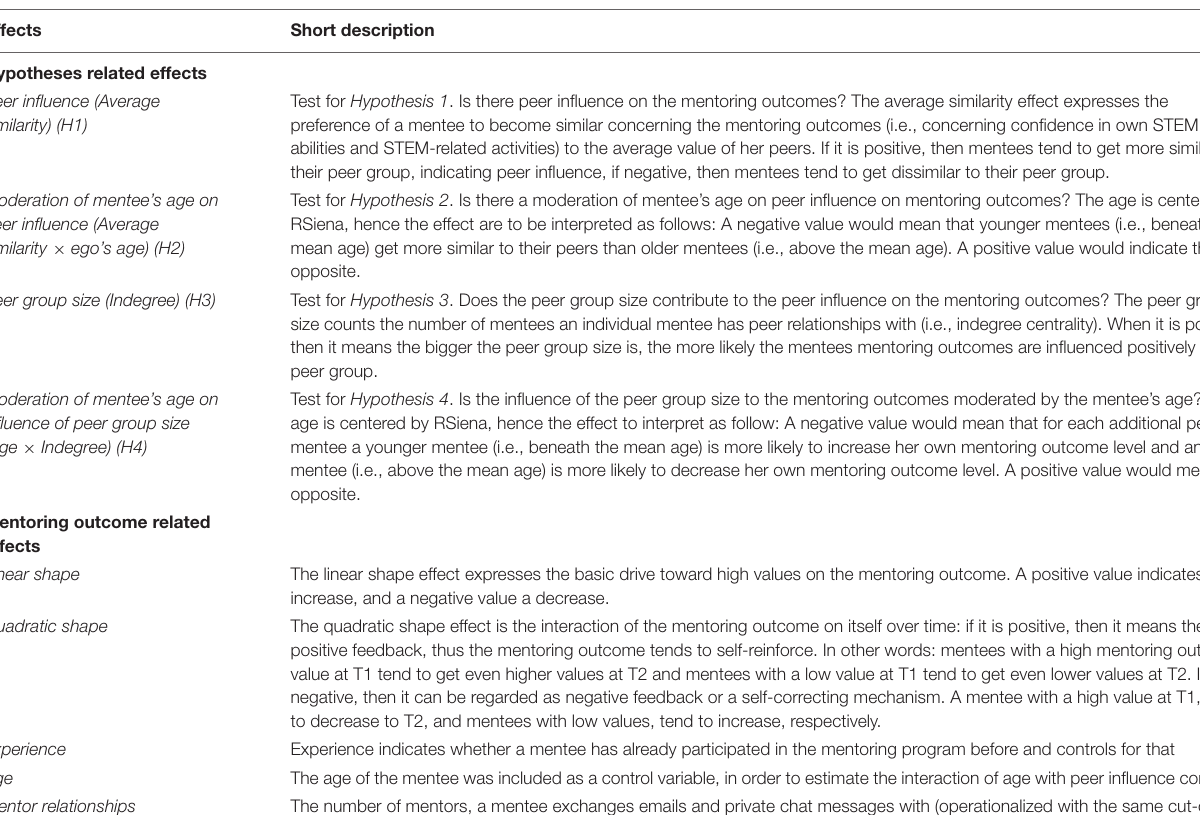
TABLE 1 | Short description of included effects for the simulation of mentoring outcomes in our RSiena